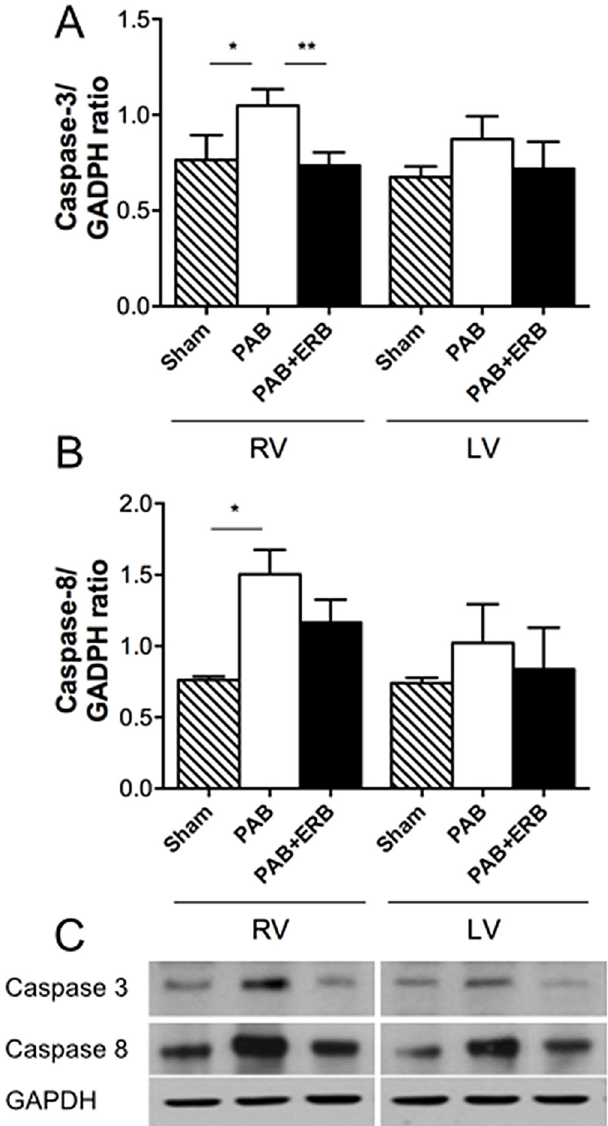
Fig 9. Western blot results of Caspase 3 and 8, peptides involved in apoptosis. Illustrated in the graphs are the quantification of Caspase 3 and 8. A) Shows caspase 3 increase with PAB compared with sham ( * p (cid:1) 0.05) and diminish with macitentan compared with PAB ( ** p (cid:1) 0.05). B) Shows caspase 8 increase with PAB compared to sham ( * p (cid:1) 0.01) however, macitentan did not significantly diminish Caspase 8. C ) Western blot examples are shown below the graphs of the respective proteins. Glyceraldehyde-3 – phosphate dehydrogenase (GAPDH) was used as the internal control. Sham (n = 4), PAB-group (n = 5), and PAB+ERB (n = 5). RV: right ventricle, LV: left ventricle, PAB: pulmonary artery banding, and ERB: endothelin receptor